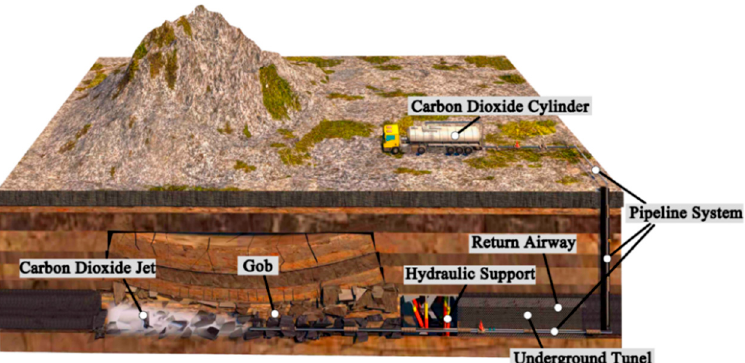
Figure 1. Schematic diagram of the CO 2 pipeline transport (direct injection) system in coal mine.